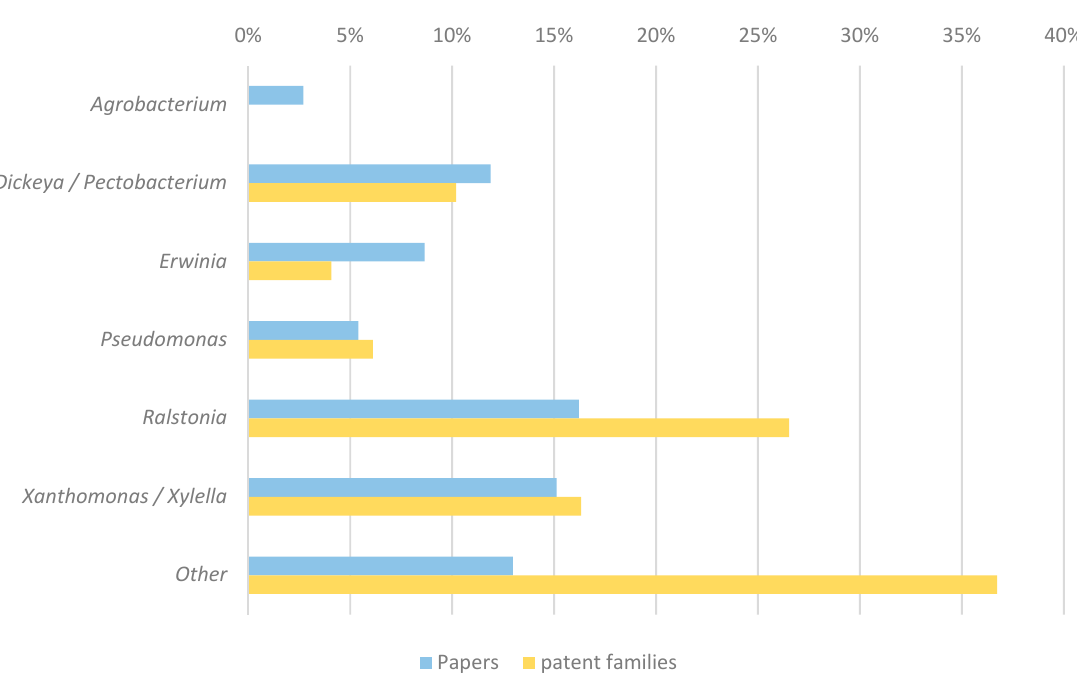
Figure 3. Distribution of patent families and scientific publications classified according to the bacterial genera that is tackled by the phage product. On the basis of Mansfield et al., 2012, seven categories ( Agrobacterium, Dickeya/Pectobacterium, Erwinia, Pseudomonas, Ralstonia, Xanthomonas/Xylella, and Other) were made to classify patent families and publications. Groupings of bacterial genera ( Dickeya/Pectobacterium and Xanthomonas/Xylella ) were created as phage cocktails were created to tackle both bacterial genera. The last category “Other” consists of patent families and publications that do not specify the bacterial pathogen that is being targeted or that tackle an alternative bacterial